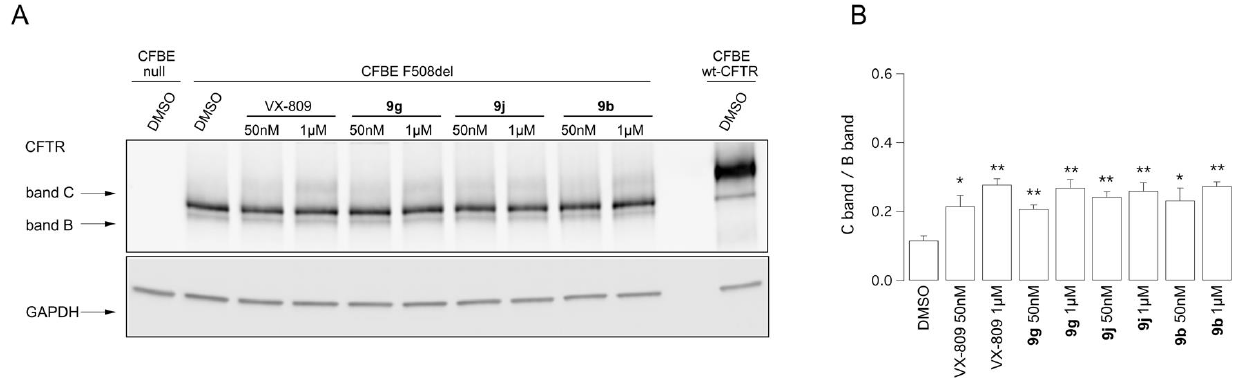
Figure 8. Biochemical analysis of the F508del-CFTR expression pattern: ( A ). The Western blot image shows the electrophoretic mobility of F508del-CFTR in CFBE41o- cells, treated for 24 h with vehicle alone or test compounds (as indicated). Arrows indicate mature, complex-glycosylated (band C) and immature, core-glycosylated (band B) forms of CFTR protein. ( B ). Quantification of the C band/B band ratio in experiments as in ( A ). Data are shown as mean ± SD ( n = 3 independent experiments). Asterisks indicate statistical significance versus negative control: * p < 0.05; ** p < 0.01.